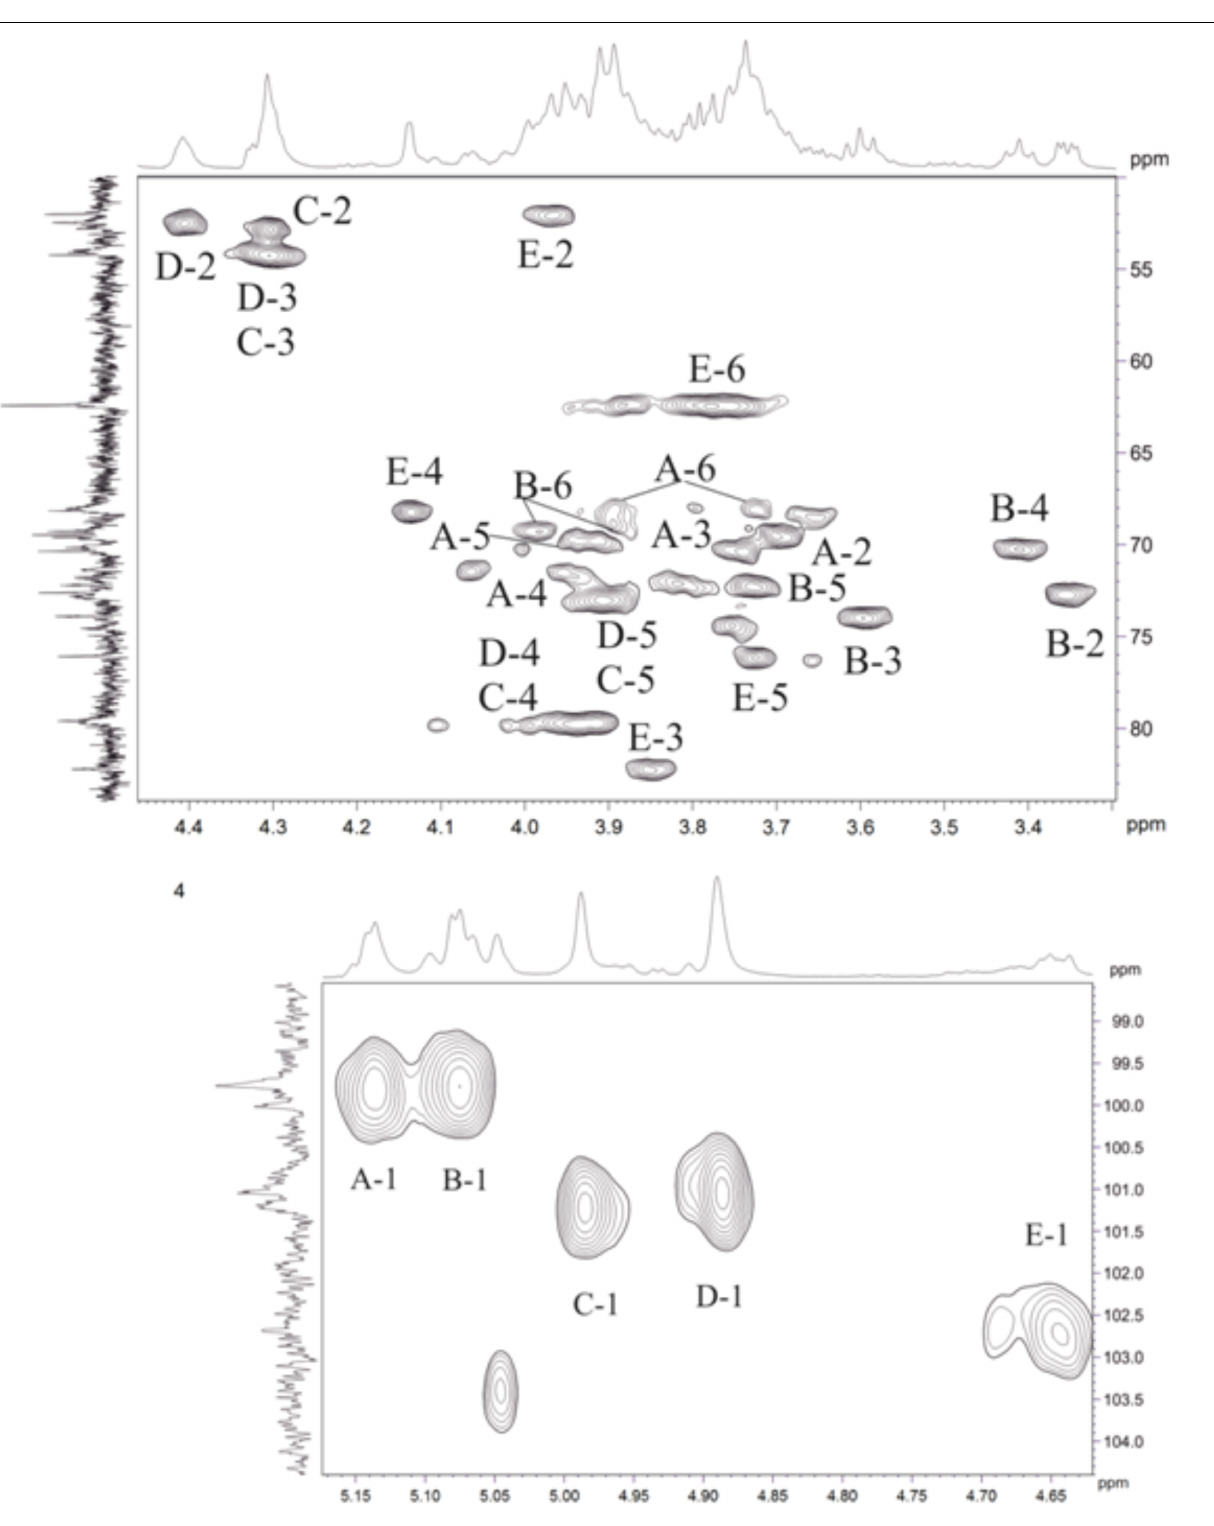
FIGURE 5 | Parts of a 2D, 1 H, 13 C multiplicity edited heteronuclear single quantum correlation (edHSQC) spectrum of the polysaccharide. The corresponding parts of the 1 H and 13 C nuclear magnetic resonance (NMR) spectra are shown along the horizontal and vertical axes, respectively. Numbers refer to protons, and the carbons of sugar units are designated by letters, as shown in Table 4